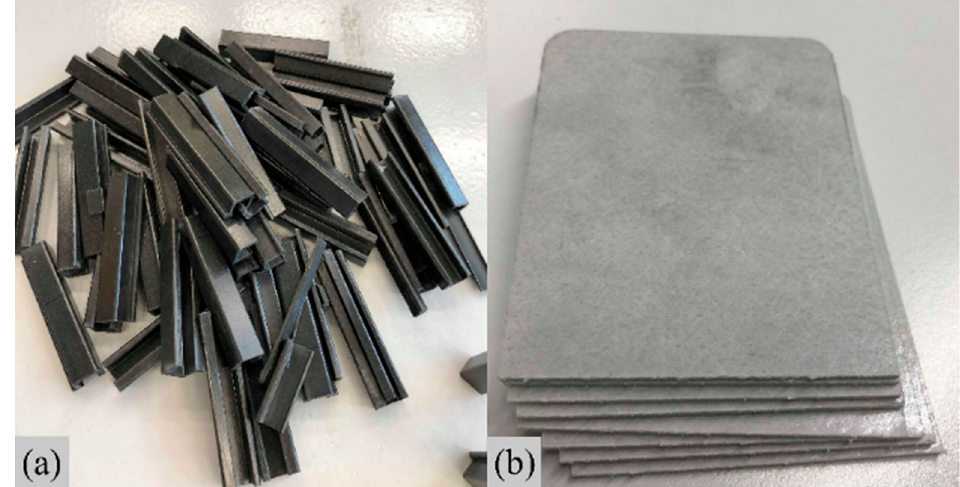
Figure 3. Discarded composite waste: ( a ) carbon fibre-reinforced epoxy composite (CFEC) and ( b ) glass fibre-reinforced polyester composite (GFPC).